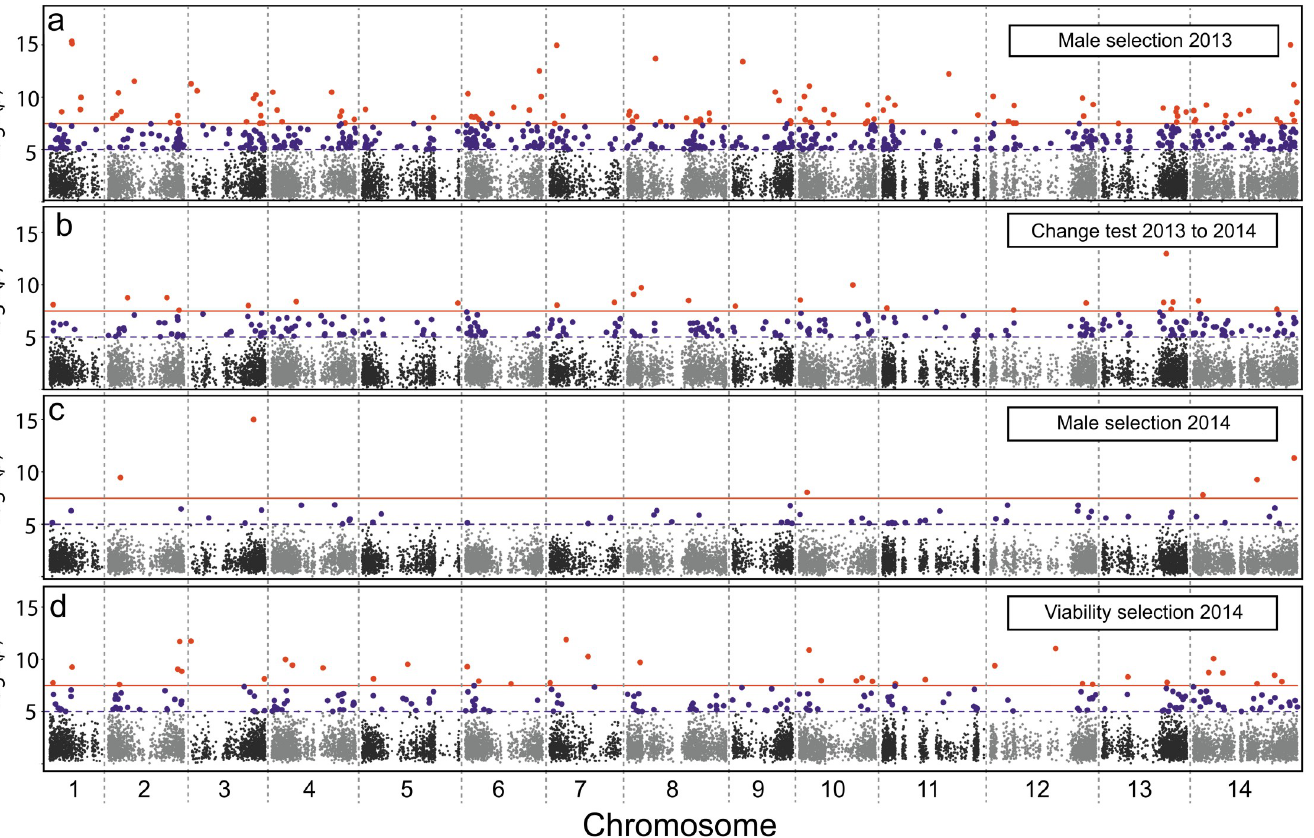
Fig 4. Manhattan plots, with a single test reported per gene, for (a) Male selection 2013, (b) Allele frequency change 2013–2014, (c) Male selection 2014, and (d) Viability selection 2014. The orange line is the Bonferroni threshold, purple is p = 10 − 5 .